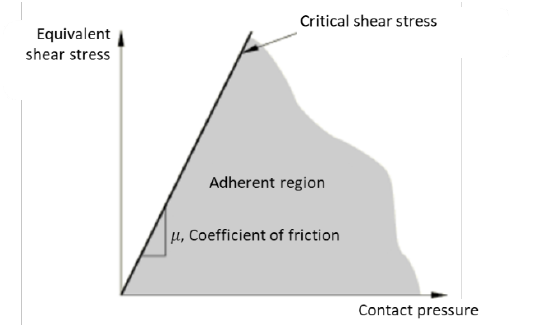
Figure 6. Sliding conditions between surfaces in contact (adapted from Dassault Systèmes S. A. [9]).